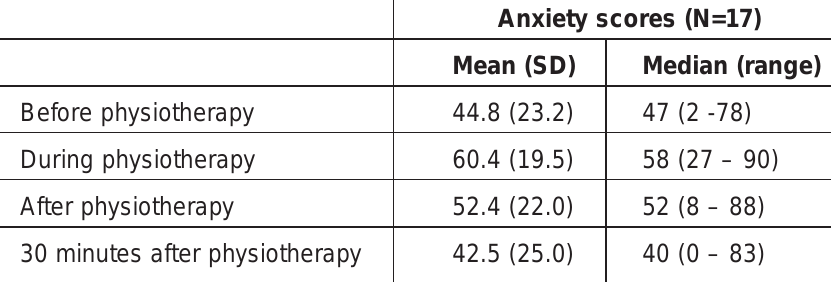
Table 2: Anxiety scores (mean and median scores) as reported by subjects before, during and after physiotherapy